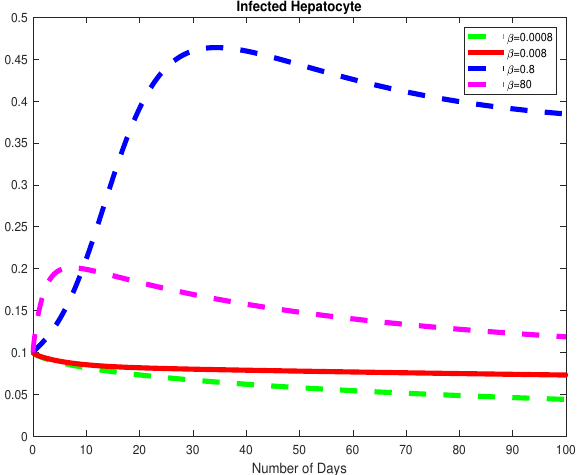
Figure 11. The dynamics of the Healthy Hepatocytes ( H ) for varying values of β .